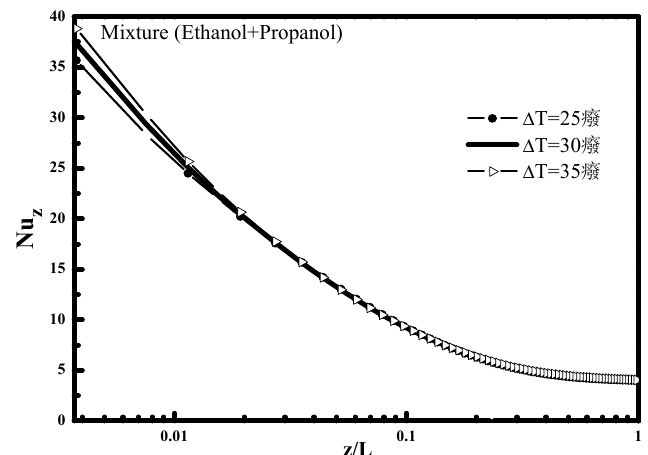
Figure 2. Variation of the mixture temperature along the tube for different Δ T.